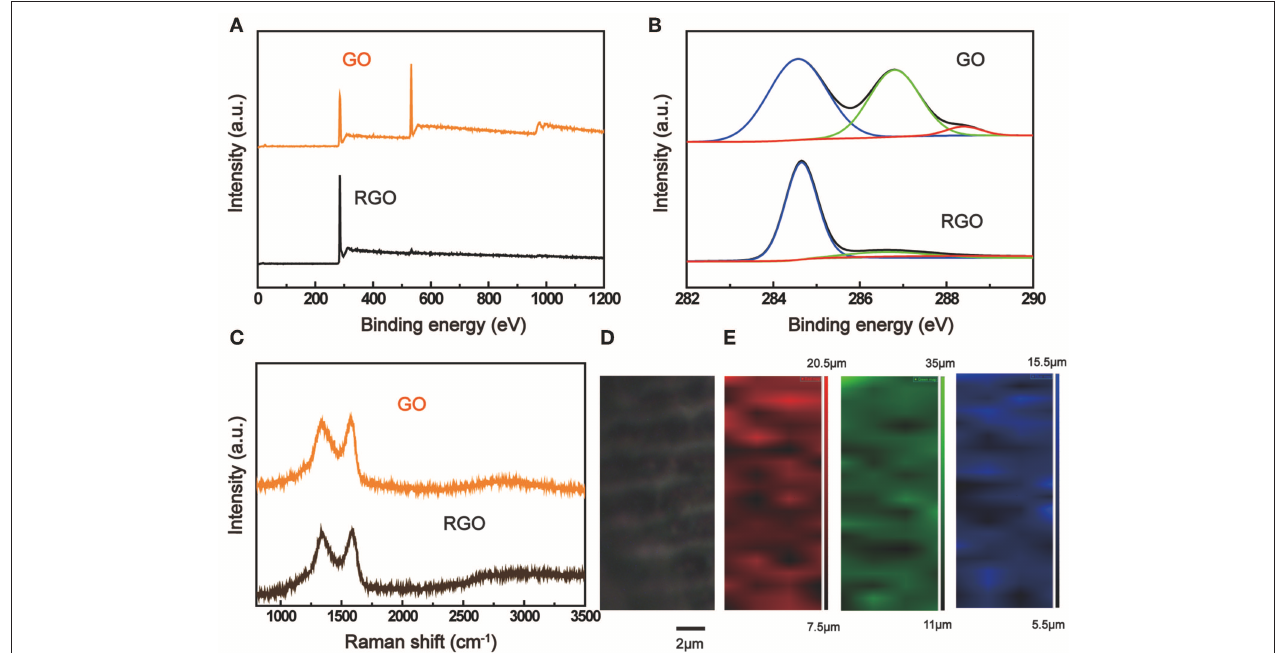
FIGURE 3 | (A) Survey XPS spectra and (B) C1s spectra of GO/RGO film measured on the GO side and RGO side. (C) Raman spectra of GO/RGO structure measured on the GO side and RGO side. (D) Optical image of RGO structure. (E) Raman mapping of (D) , corresponding to wave number from 1,300–1,500, 1,500–1,800, 2,200–2,800 cm − 1 ,